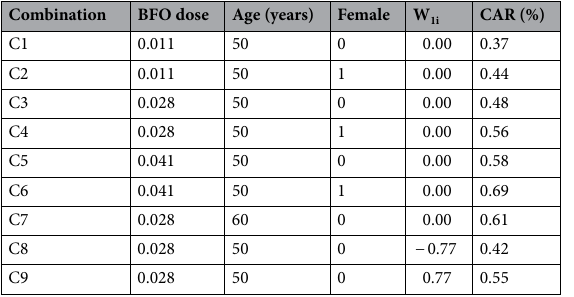
Table 4. Combinations of predictors used in Fig. 4 and model-based estimates of % CAR. For ease of readability, CAR is expressed here as a percent (100 × CAR).